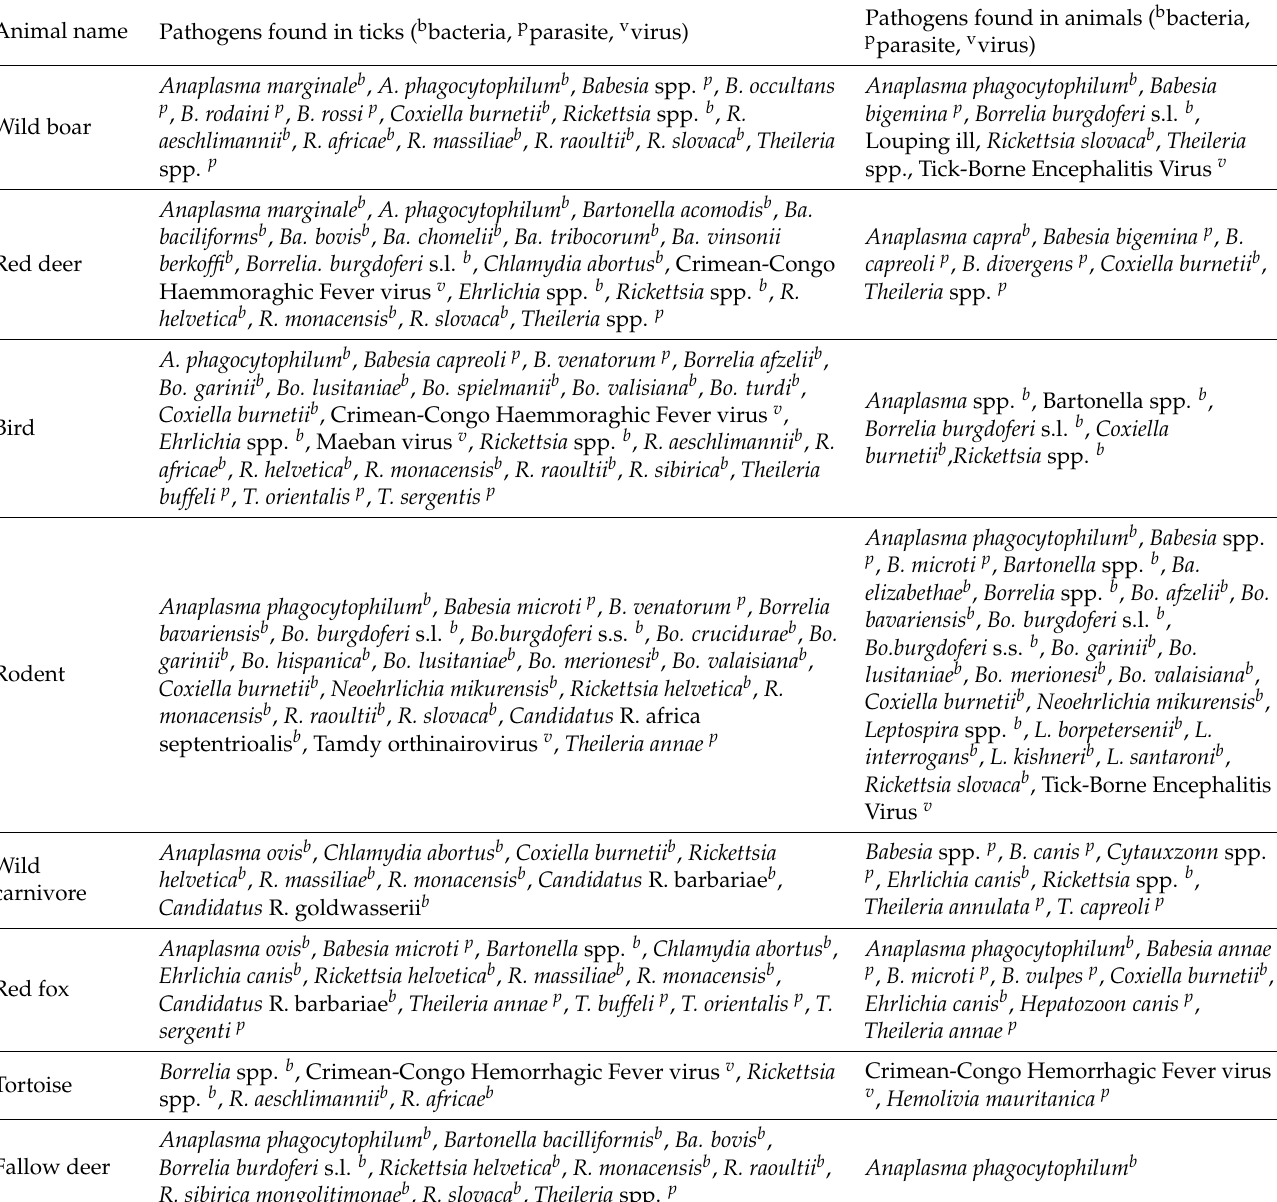
Table 2. TBPs detected in wild animal and their ticks in the Mediterranean